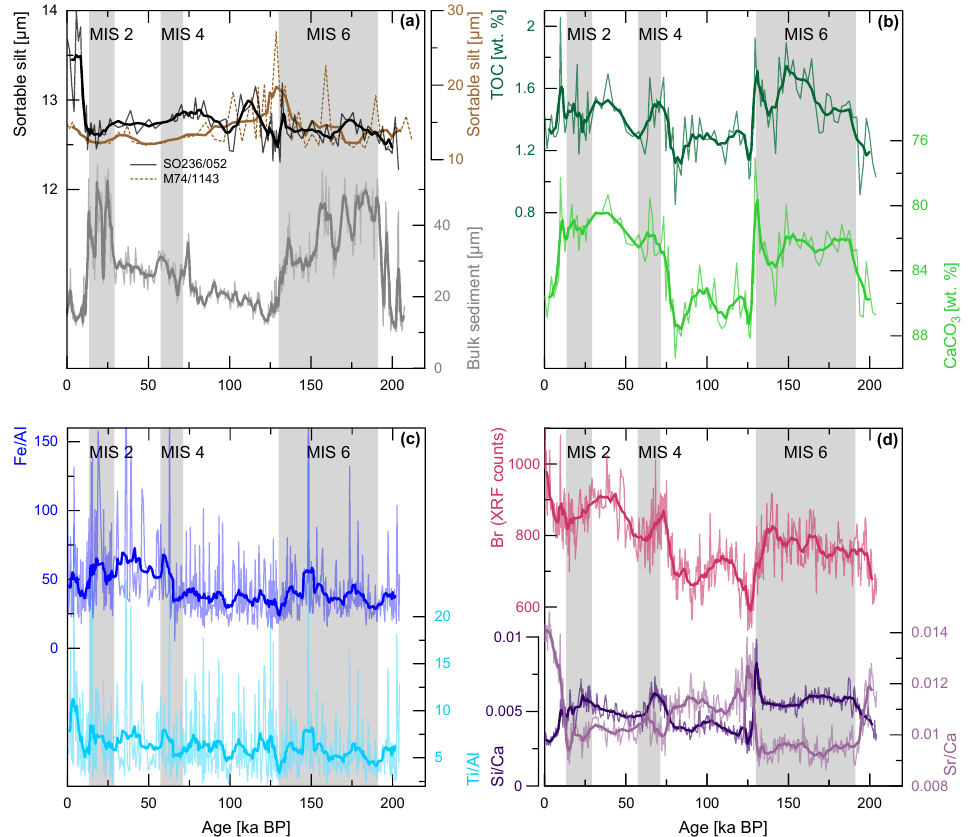
Figure 5. Sedimentological and geochemical records of sediment core SO236-052-4 from the central part of the Maldives Inner Sea. (a) Sortable silt (black) in comparison with the data of core M74/4-1143 (brown) and bulk sediment (grey) mean values, (b) total organic carbon (TOC) (dark green) and calcium carbonate (light green) content of the sediment, (c) iron (dark blue) and titanium (light blue) in relation to the aluminium XRF counts and (d) bromine XRF counts (pink), and silicon (dark purple) and strontium (light purple) in relation to the calcium XRF counts. Thin lines represent full-resolution data, bold lines in panels (a) and (b) indicate 5-point running averages, whereas all XRF counts in panels (c) and (d) are displayed as 15-point running averages (bold lines). MIS denotes the marine stable oxygen isotope